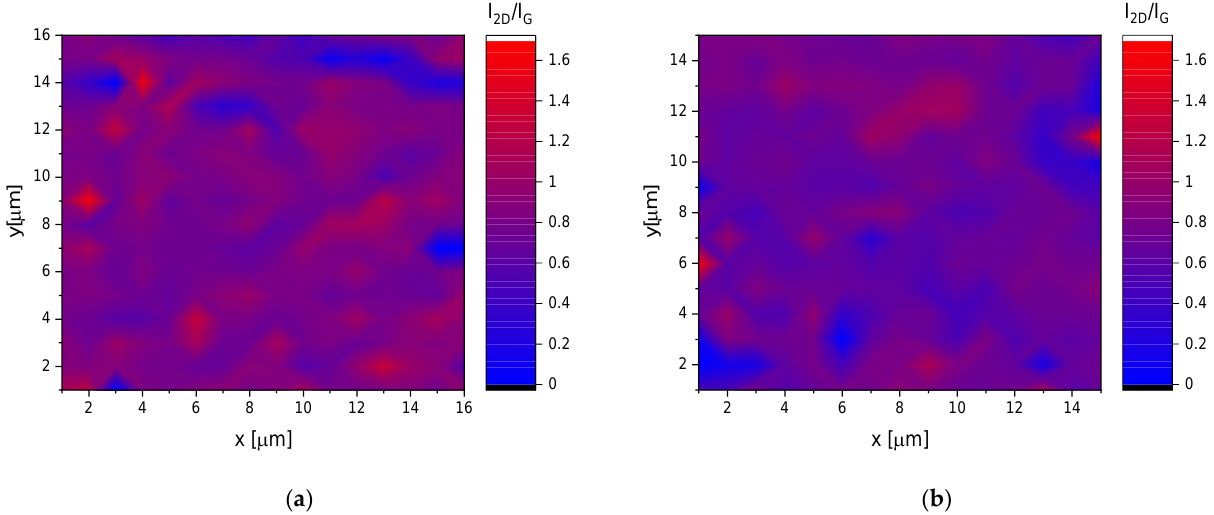
Figure 7. Map made on the basis of Raman spectra collected for a sample deposited at 900 °C ( a ) and 1000 °C ( b ).